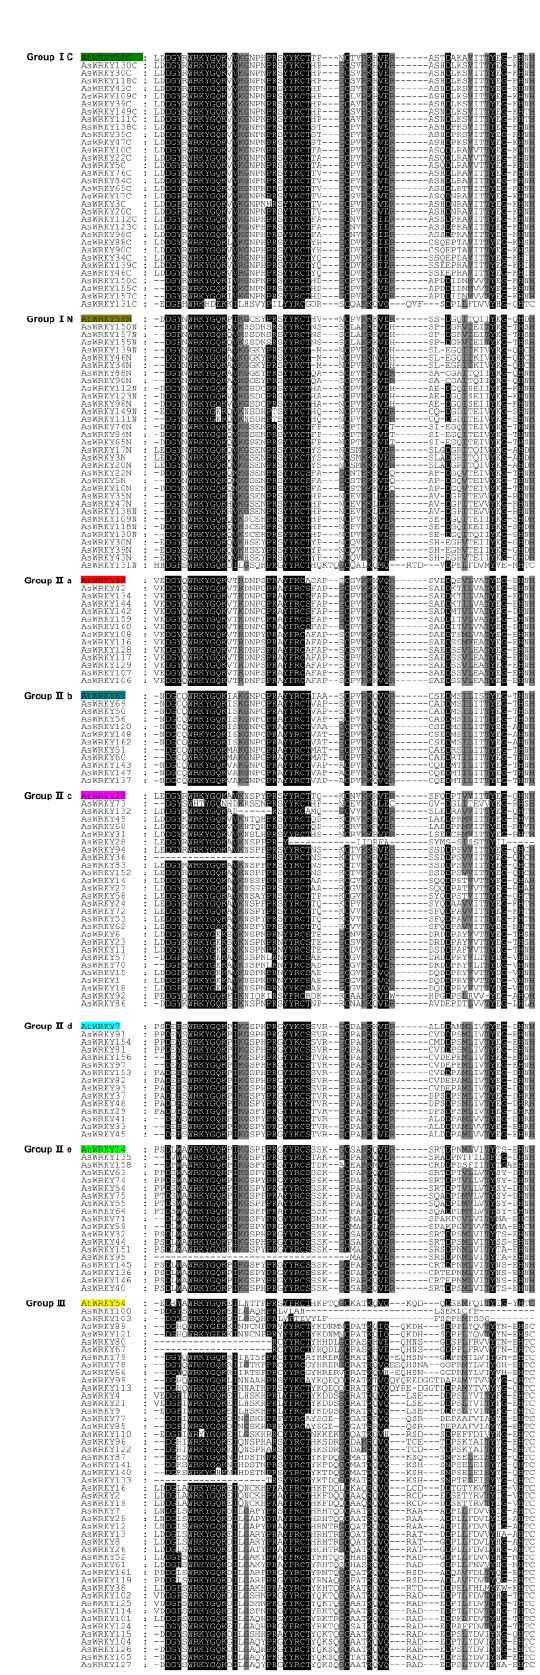
Figure 1. Multiple sequence alignments of AsWRKY and selected AtWRKY genes.